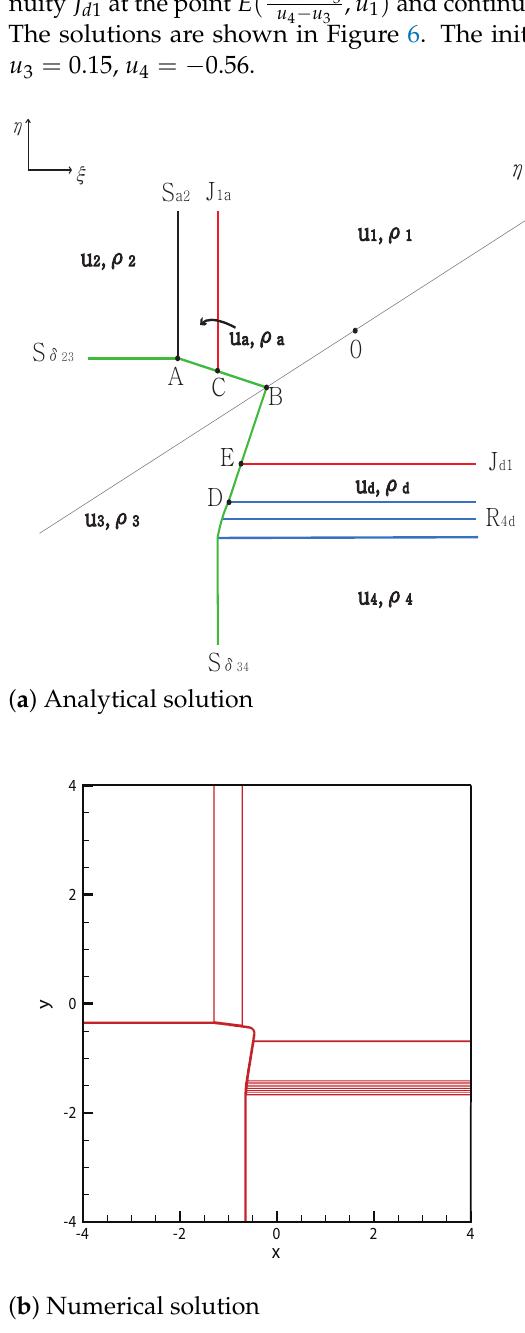
Figure 6. Case 6. JS + S δ + S δ + RJ